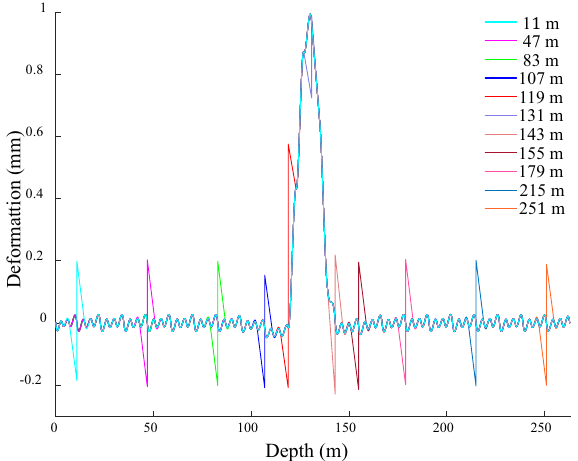
Figure 13. GRD in x -direction under bending when bunton is disconnected from GR.